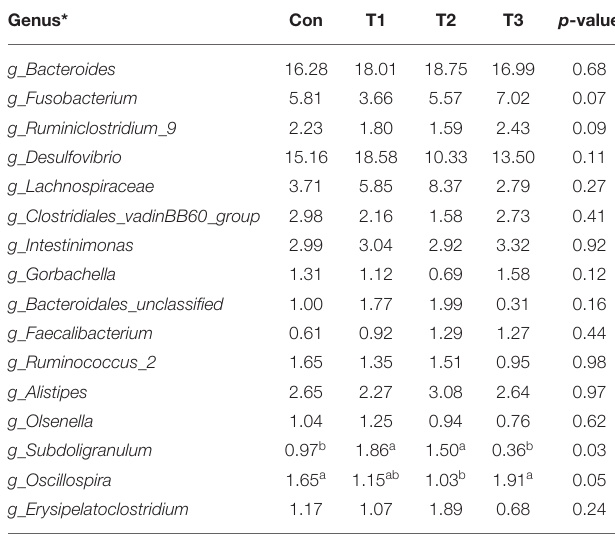
TABLE 8 | Phylum-level relative abundances of fecal microbiota in ducks with different dietary treatments (%). Phylum*